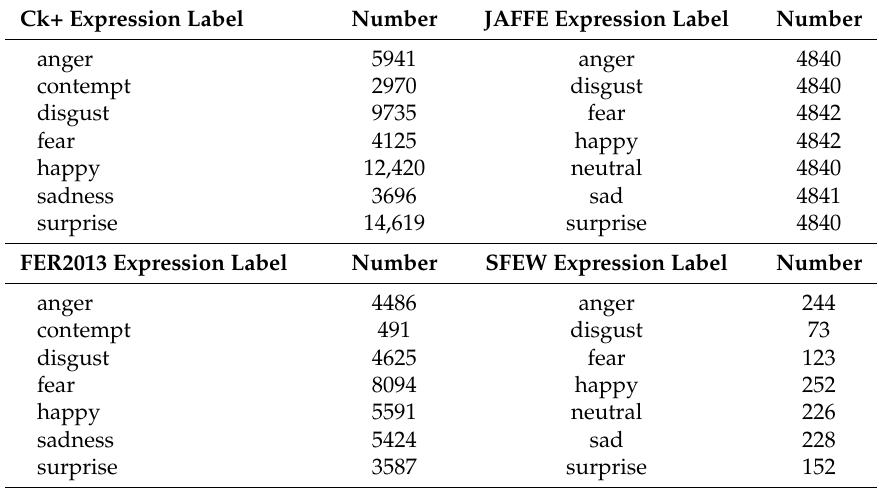
Table 1. The number of data augmentation on CK+, JAFFE, FER2013 and